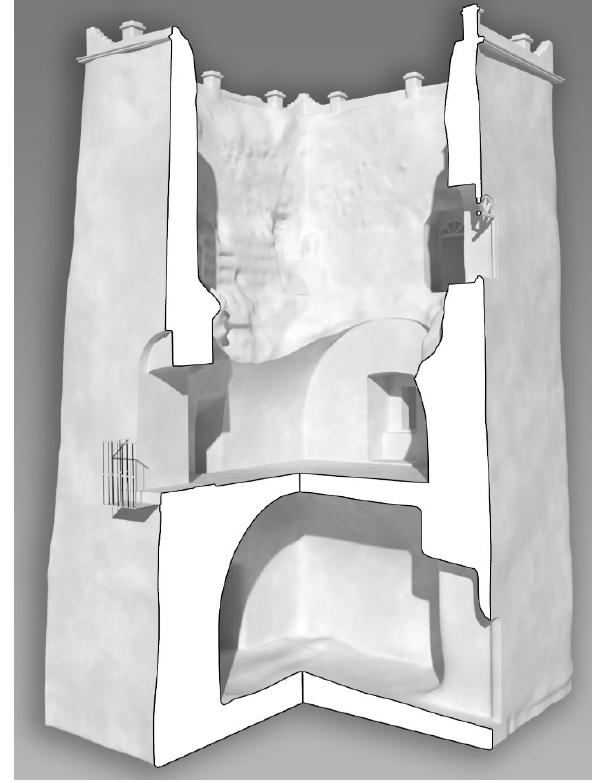
Figure 4. 3D model with cross sections made into